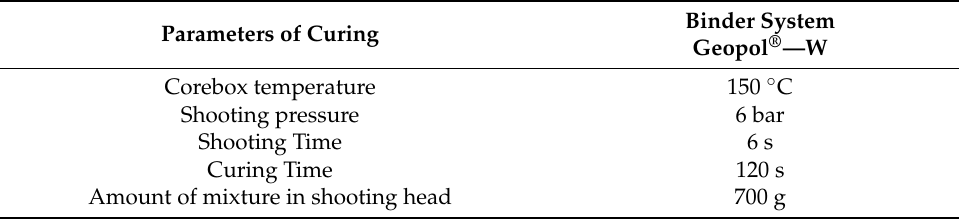
Table 1. Parameters for the production of test specimens for the evaluation of mechanical properties of mixtures and test